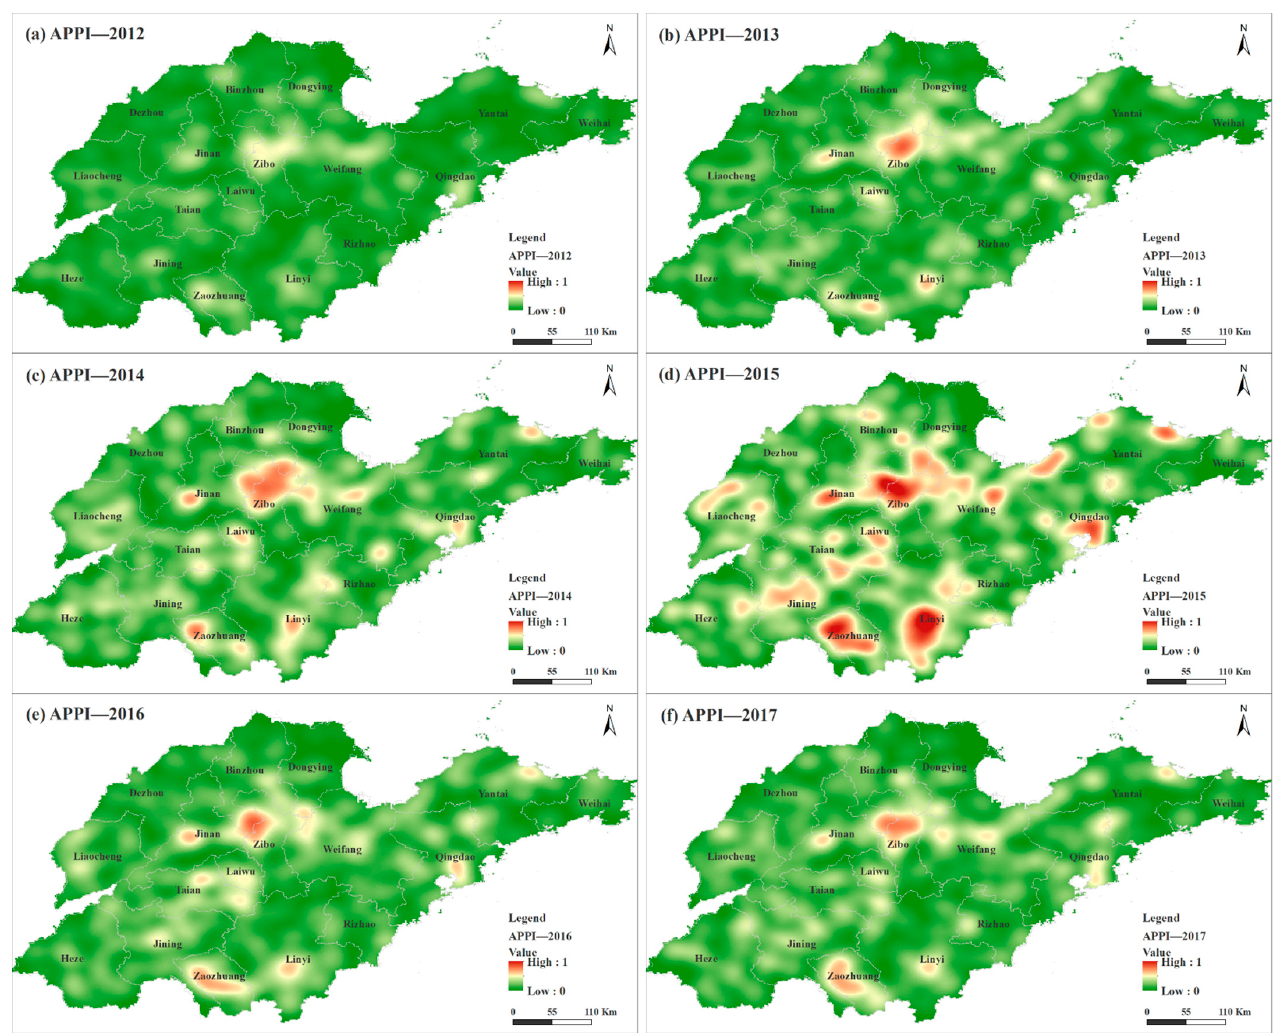
Figure 4. The results of APPI in Shandong Province from 2012 to 2017.